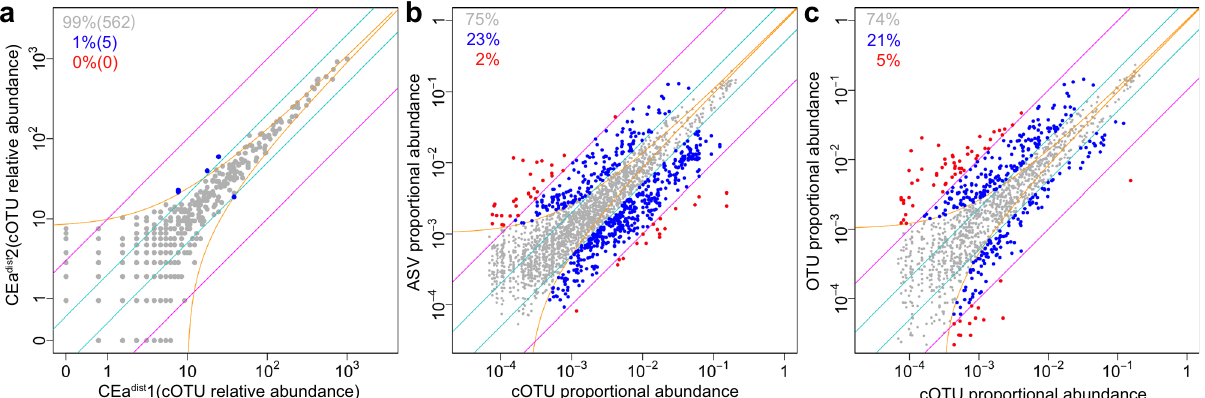
Fig. 4 Highly reproducible quanti fi cation of BarBIQ and comparison with conventional methods. a Comparison (dots) of the relative abundances of cOTUs between a pair of technical replicates (other pairs in Supplementary Fig. 12). Orange lines, theoretical con fi dential interval (99.9%) for sampling noise based on the Poisson distribution and normalization to the relative abundance (to the proportional abundance for b and c ); cyan lines, 2-fold change; magenta lines, 10-fold change; blue dots, cOTUs that showed larger difference than that of the sampling noise and 2-fold change and was smaller than the 10-fold change; proportions and numbers in the parentheses, proportions and the numbers of dots in corresponding colors, respectively; CEa, mouse; dist and prox, locations; 1 and 2, technical replicates (see text). b Comparison between the proportional abundances of the common pairs of cOTUs and ASVs with all 16 cell-samples shown in the same format as a . Red dots, common pairs of cOTUs and ASVs that showed larger difference than the sampling noise and 10-fold change. c Comparison between the proportional abundances of the common pairs of cOTUs and OTUs with all 16 cell-samples shown in the same format as a and b . Source data are provided as a Source Data fi three databases (Fig. 3b, Methods section, Supplementary Data 1).